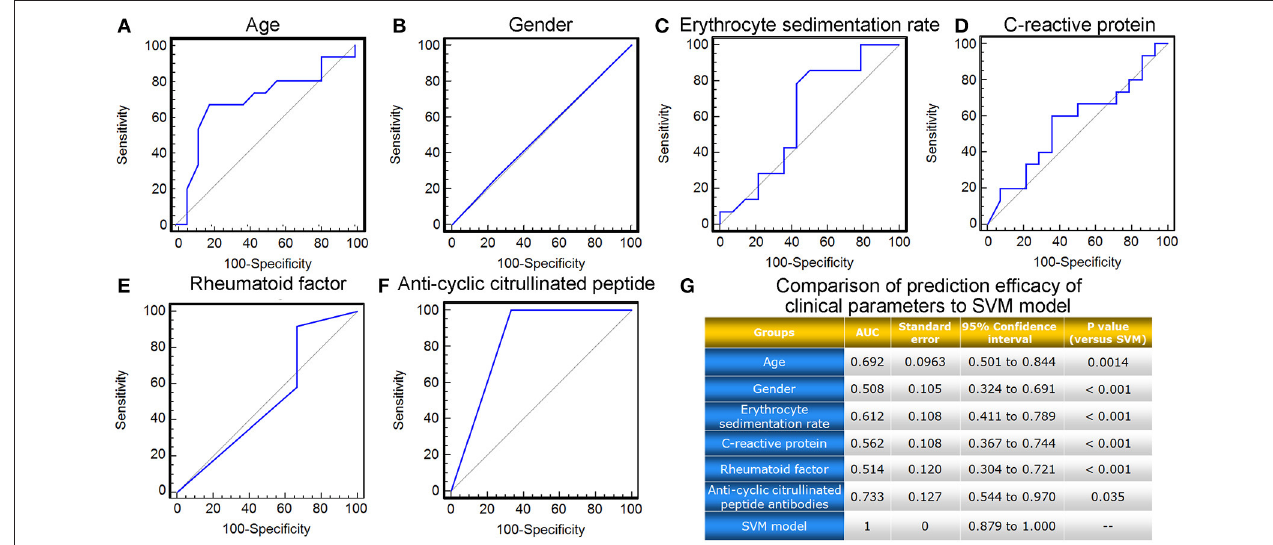
FIGURE 6 | ROC comparison of various clinical parameters with the SVM-based model in predicting response to TG tablets. (A–F) ROC curves of age, gender, erythrocyte sedimentation rate, C-reactive protein, rheumatoid factor and anti-cyclic citrullinated peptide antibodies in predicting response to TG tablets. (G) Statistical significance in ROC comparisons of various clinical parameters with the SVM-based model in predicting response to TG